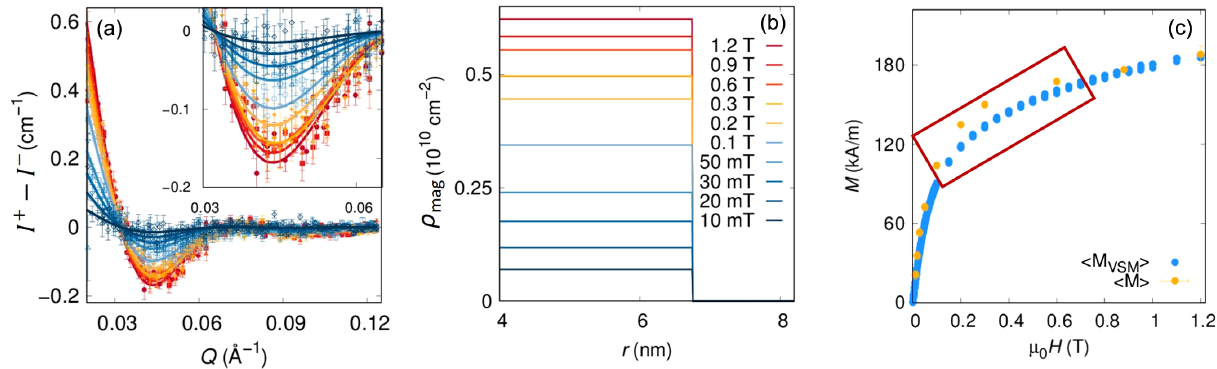
FIG. 13. (a) Nuclear-magnetic scattering interference term I þ − I − (points) at various applied magnetic fields [same color code as in (b)] and corresponding fits (lines). Inset: Enlarged region of Q ¼ 0 . 03 – 0 . 065 Å − 1 . (b) Field-dependent magnetic scattering length density ρ profiles. (c) Macroscopic longitudinal magnetization h M measured at room temperature in comparison with the mag VSM i particle volume averaged magnetization h M i as derived from SANSPOL. Deviation in the intermediate field range is indicated (red